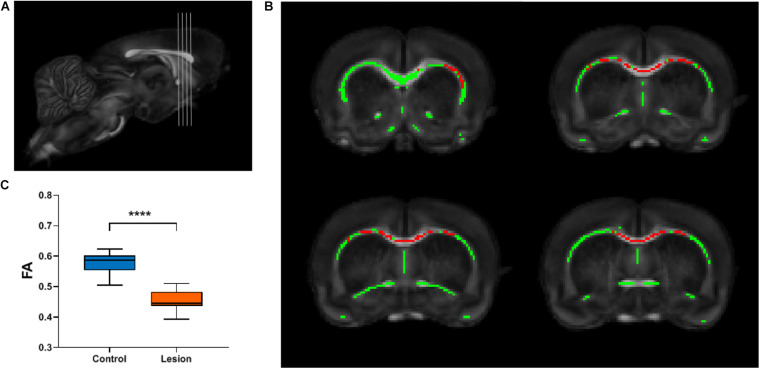
TBSS analysis reveals the white matter regions showing significant FA decreases in the lesion group. (A) Gray lines in the rat brain indicate different slices chosen for display in (B). (B) The white matter skeleton is shown in green overlaid on the averaged FA map registered in a common space. Red color represents white matter skeleton with significant FA decrease in the lesion group compared with the control group (p < 0.05, multiple comparisons corrected). (C) Box plots of the FA values of the corresponding white matter regions in the individual space of the TBSS-detected skeleton regions shown in (B). Student’s t-test was performed and **** means p < 0.0001.